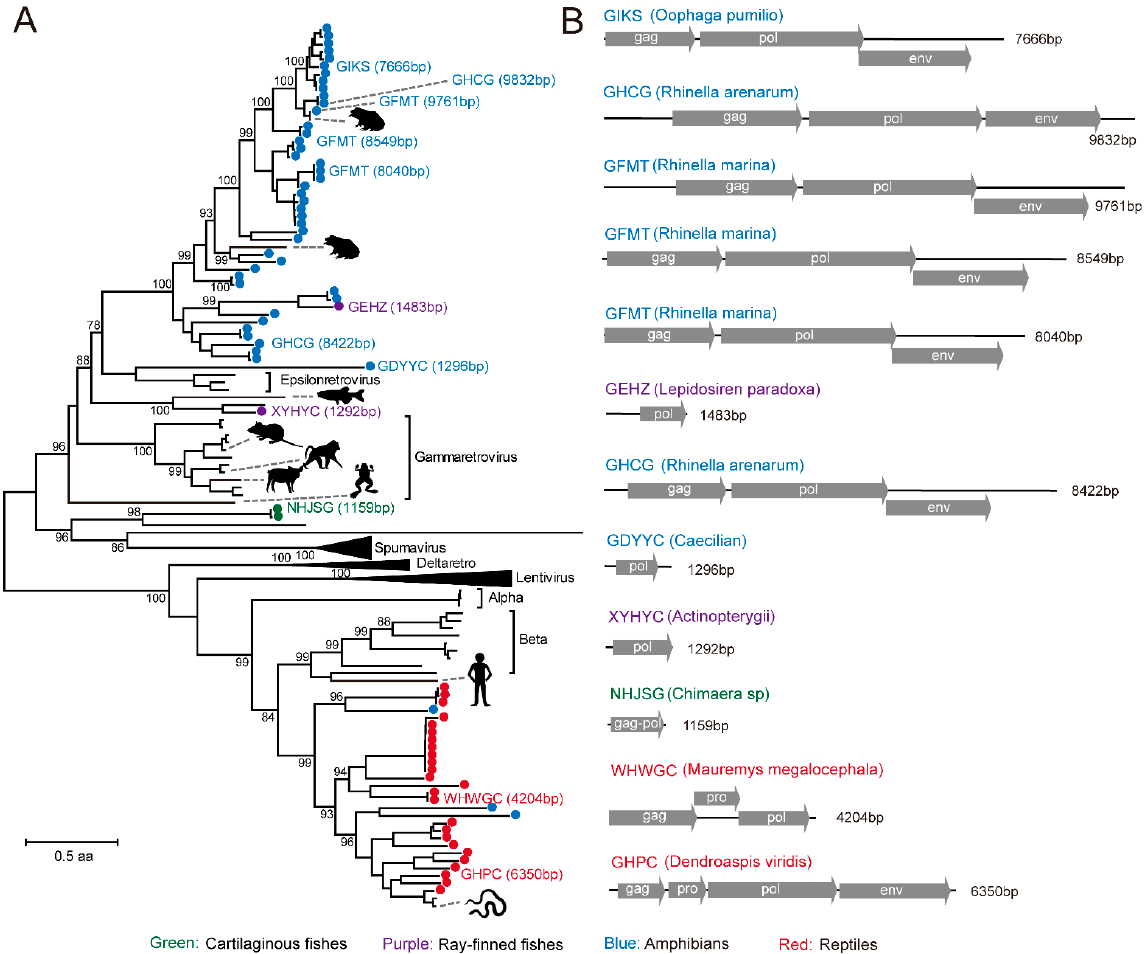
Figure 5. Genome structure and evolutionary analysis of retrovirus-like elements discovered from metatranscriptomics and transcriptomics data. ( A ) Maximum likelihood phylogenetic tree based on newly discovered retro-like virus elements and members of the family Retroviridae . ( B ) The structures of ORFs predicted from the retro-like virus elements in lower vertebrate hosts. Tree is midpoint rooted and scaled to the number of amino acid substitutions per site. Newly discovered EVEs are shown in sold circles in each tree, which are color coded to reflect the host group of each virus or EVE. Branch support values (>70%) are shown at the key